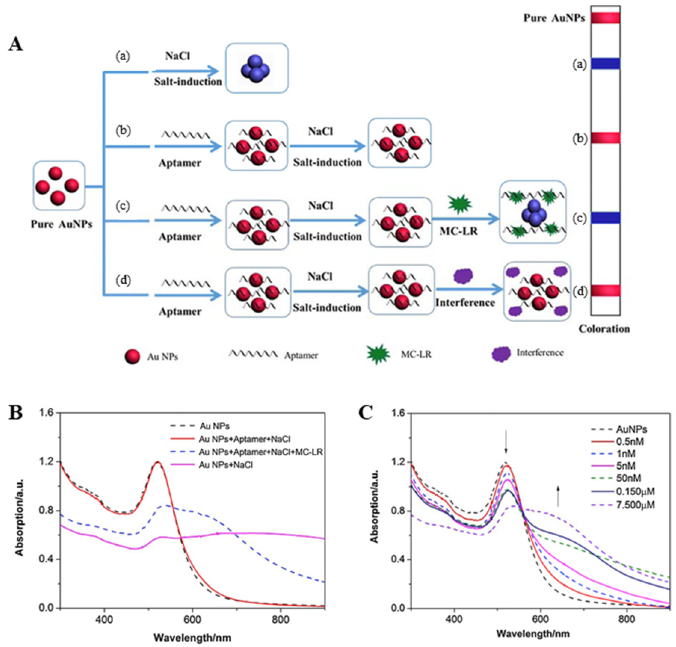
Figure 3. ( A ) Schematic illustration of the colorimetric sensor and mechanism of analytic determi- nation of MC-LR. ( B ) UV–VIS absorption spectra of AuNPs under different experimental conditions, c(Au NPs) = 4.4 nM, c(aptamer) = 0.128 uM, c(NaCl) = 24 mM, c(MC-LR) = 750 nM, T = 298K.C. ( C ) UV–VIS absorption spectrum of Au NPs (concentration range of MC-LR: 0.5 nM–7.5 𝜇 M). Repro- duced with permission from [77], published by Elsevier, 2016.